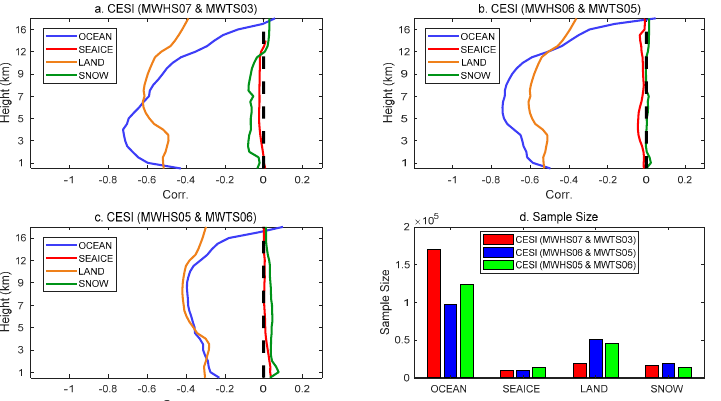
Figure 11. Same as Figure 9 except for the total profile correlation. The subfigures ( a – c ) represent results for CESI low , CESI mid and CESI high , respectively. The sample size after collocation over different surface types is shown in ( d